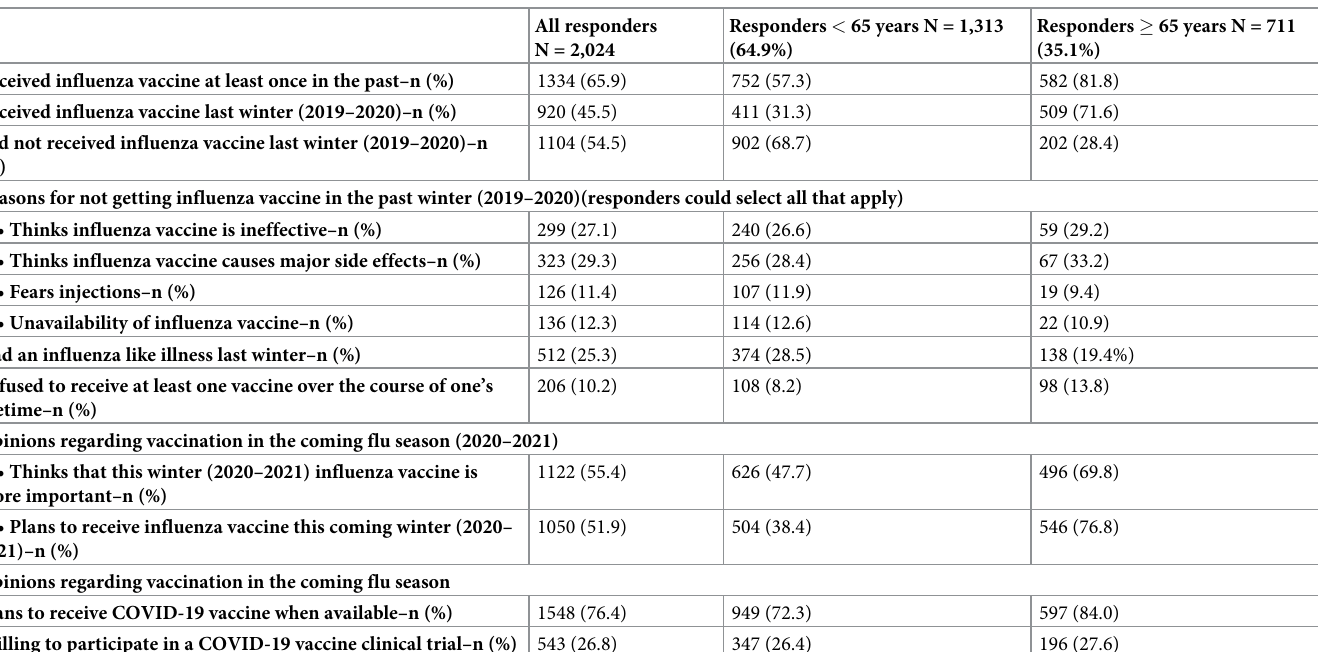
Table 2. Attitudes towards influenza, and COVID-19